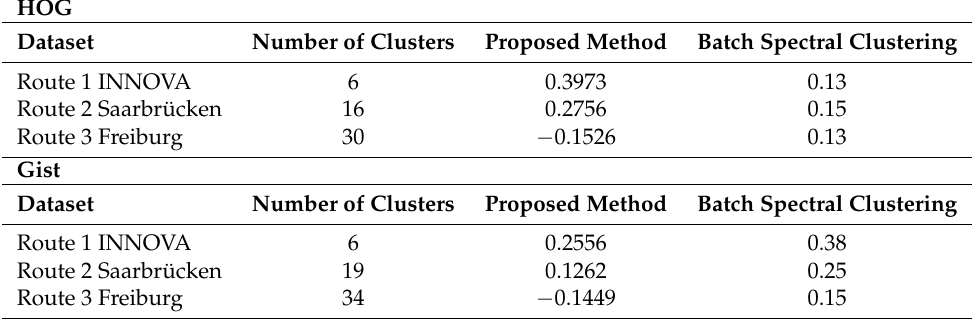
Table 3. Comparison between the maximum silhouette obtained with the proposed method and the silhouette obtained with a batch spectral clustering with the same number of